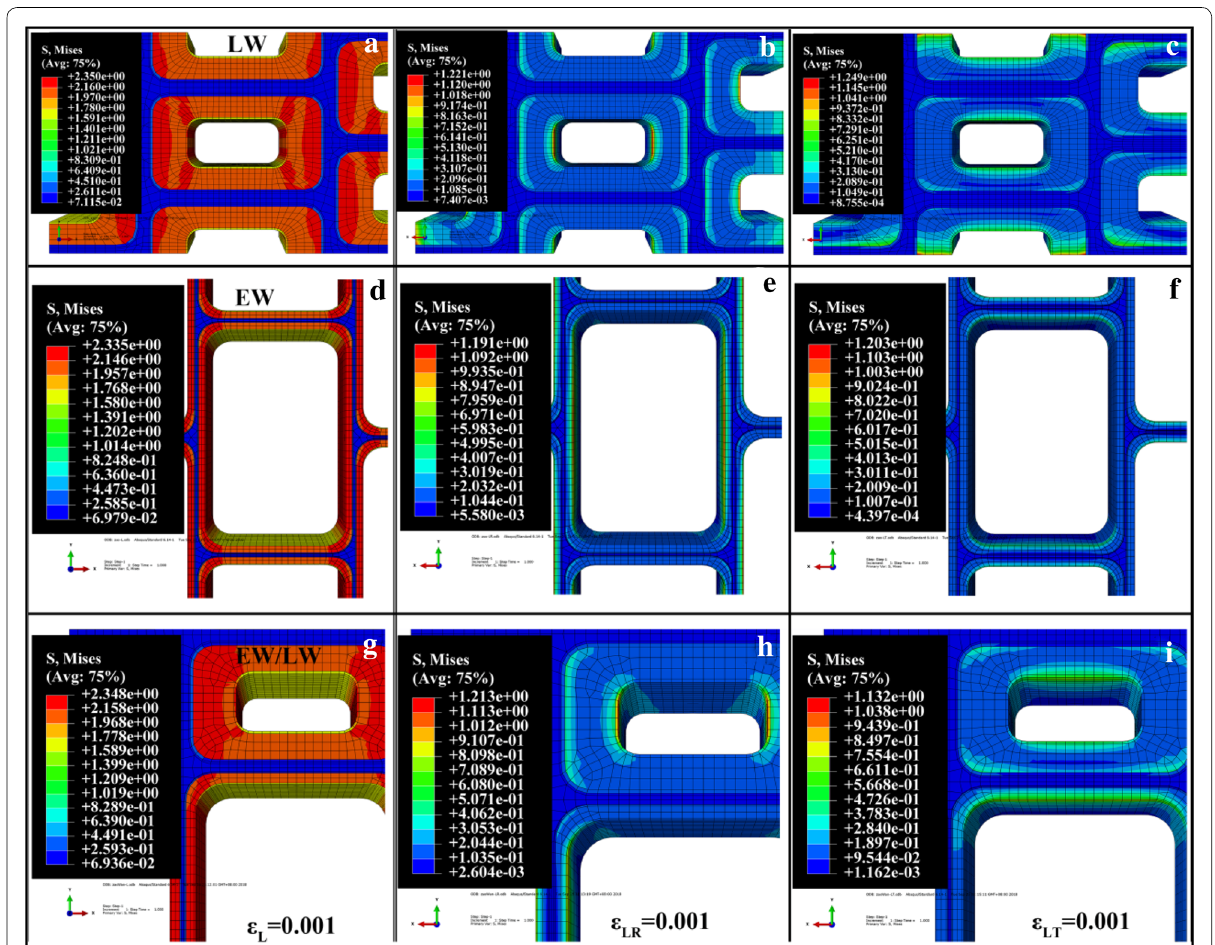
Fig. 5 Maximum principal stress distributions corresponding to loading